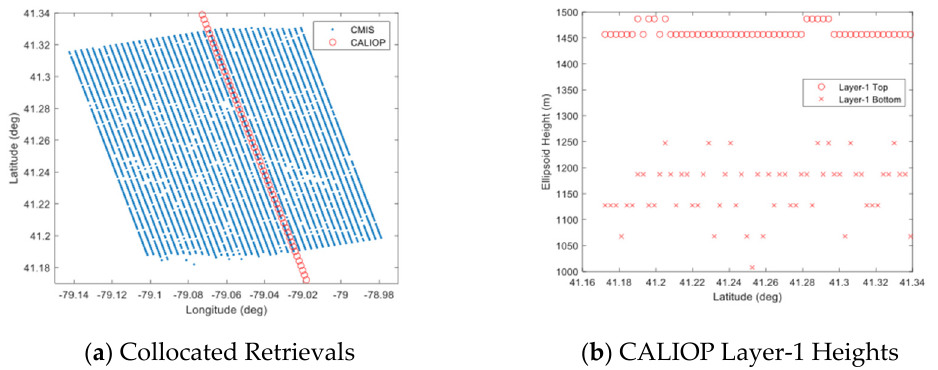
Figure 14. ( a ) CMIS retrieval sites for Hold D1 are collocated in space and time with those of CALIOP and ( b ) CALIOP layer-1 cloud tops and bottoms show nearly constant CTHs in the curtain over the collect. A feature template is centered at each retrieval site indicated by the blue dots. CALIOP heights from the 333-m cloud-layer product have been referenced to the WGS-84 ellipsoid by adding the geoid height of − 33 m at the center of the collect.